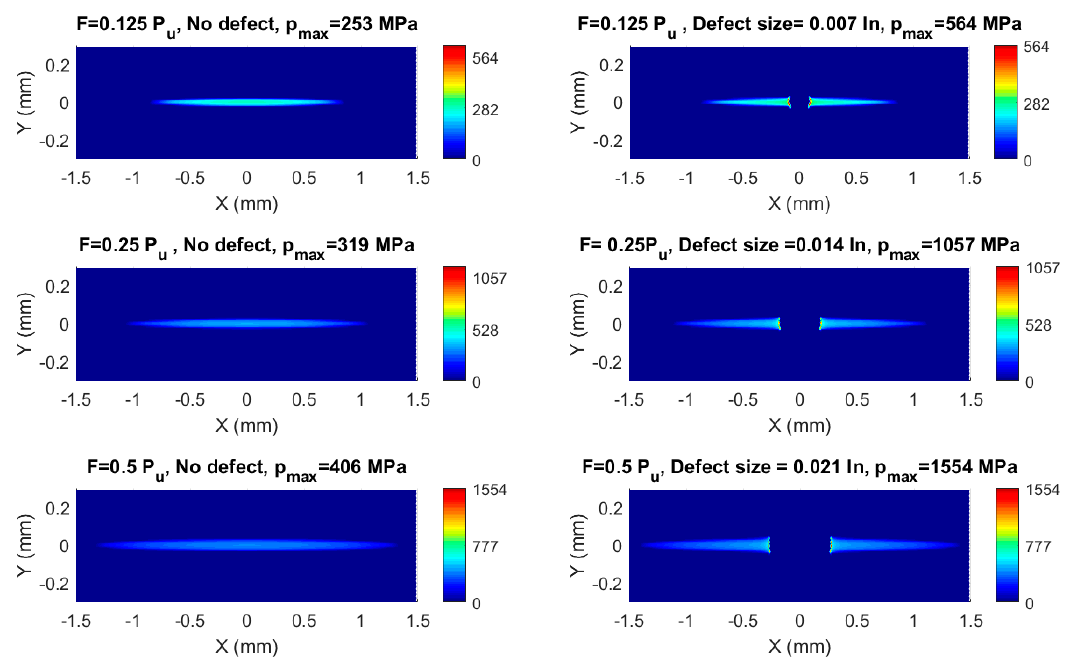
ff erent load levels and defect